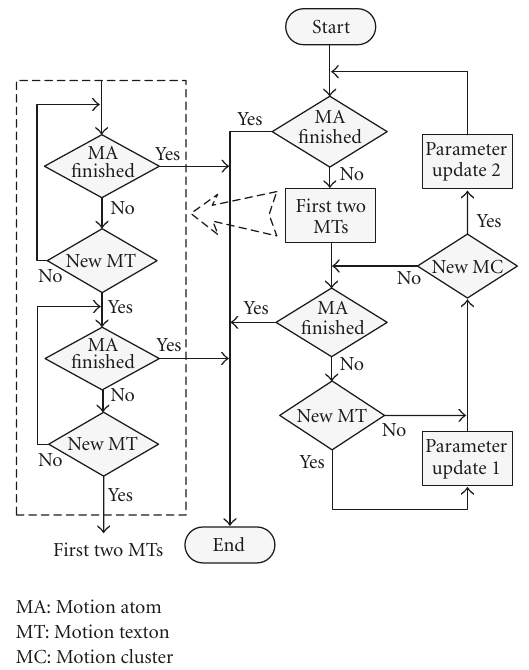
Figure 3: Motion structure parsing procedure in TVM; left: the detail of the first two MTs , right: the whole procedure.